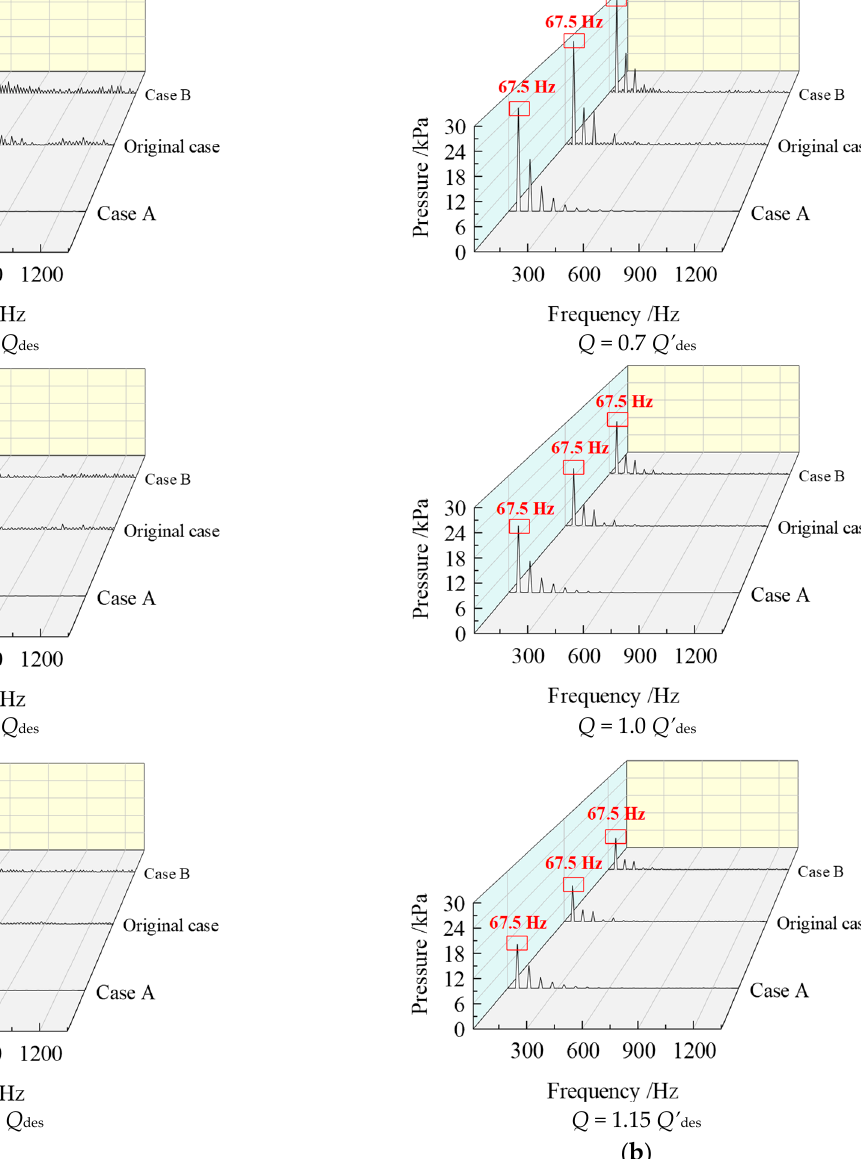
Figure 21. The frequency domain of pressure signal on B1 of three cases under ( a ) forward condition and ( b ) reverse condition.